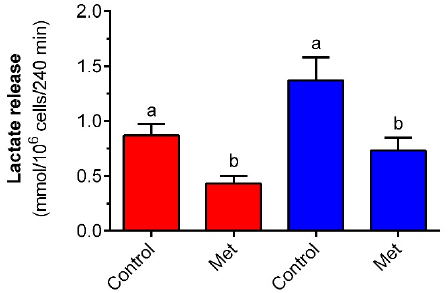
Figure 7. The effects of metformin on lactate release from isolated rat adipocytes in the presence of low and high concentrations of glucose. Adipocytes were incubated for 4 h with or without 1 mM metformin in buffer containing 3 mM glucose (red bars) or 12 mM glucose (blue bars). After the end of the incubations, adipocytes were removed and the lactate content in the buffer was determined. Epi—epinephrine, Met—metformin. The obtained results represent the mean ± SEM from 3 independent experiments in 5 repetitions ( n = 15). Values marked by different letters within each experimental group differ significantly at p < 0.05.